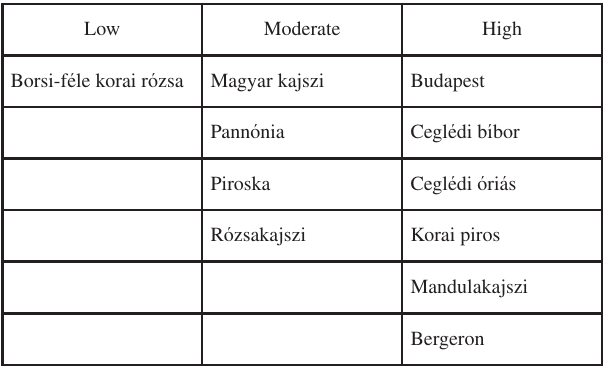
Table 2: Monilinia spp. susceptibility classes of apricot cultivars (Kecskemét, means of